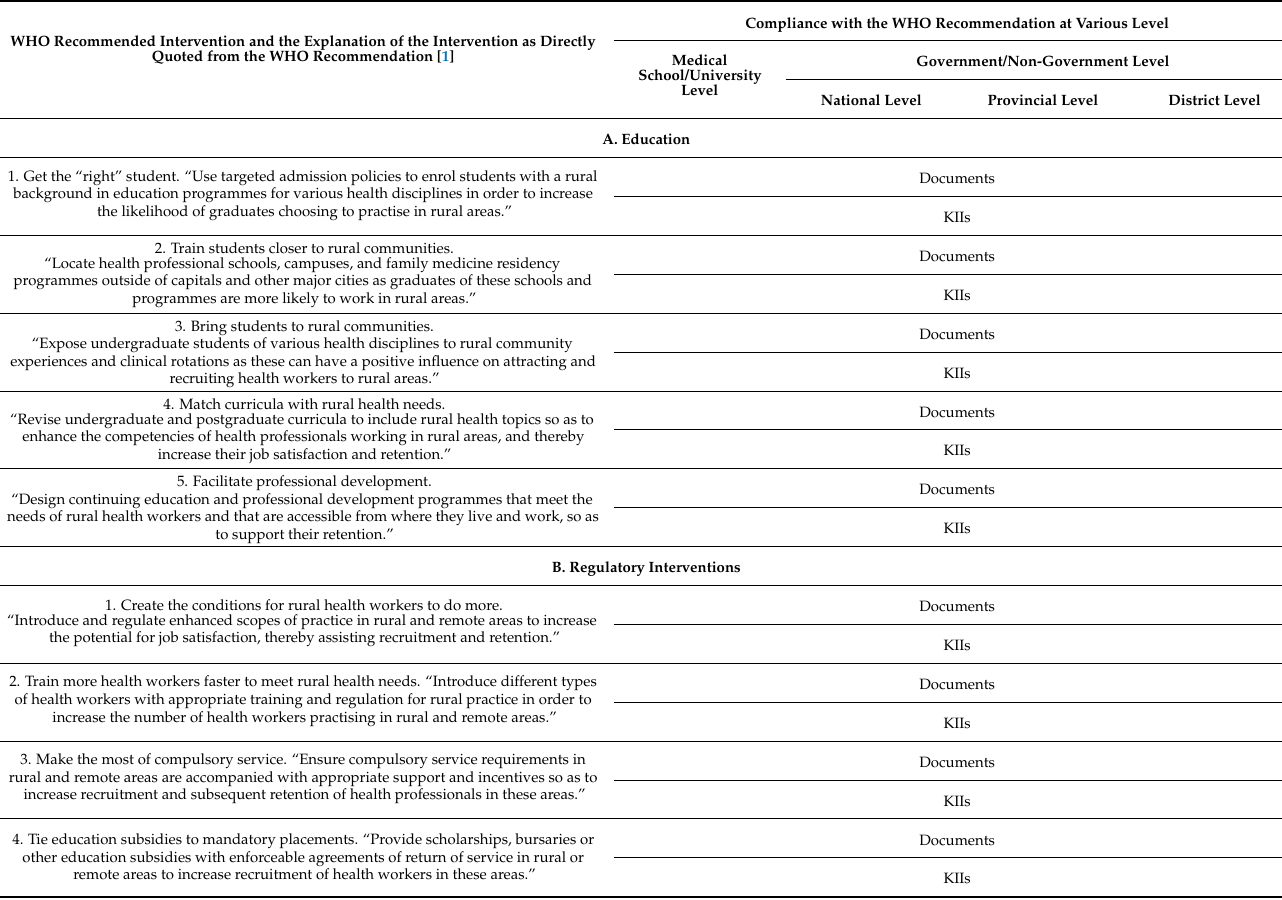
Table A1. Framework for